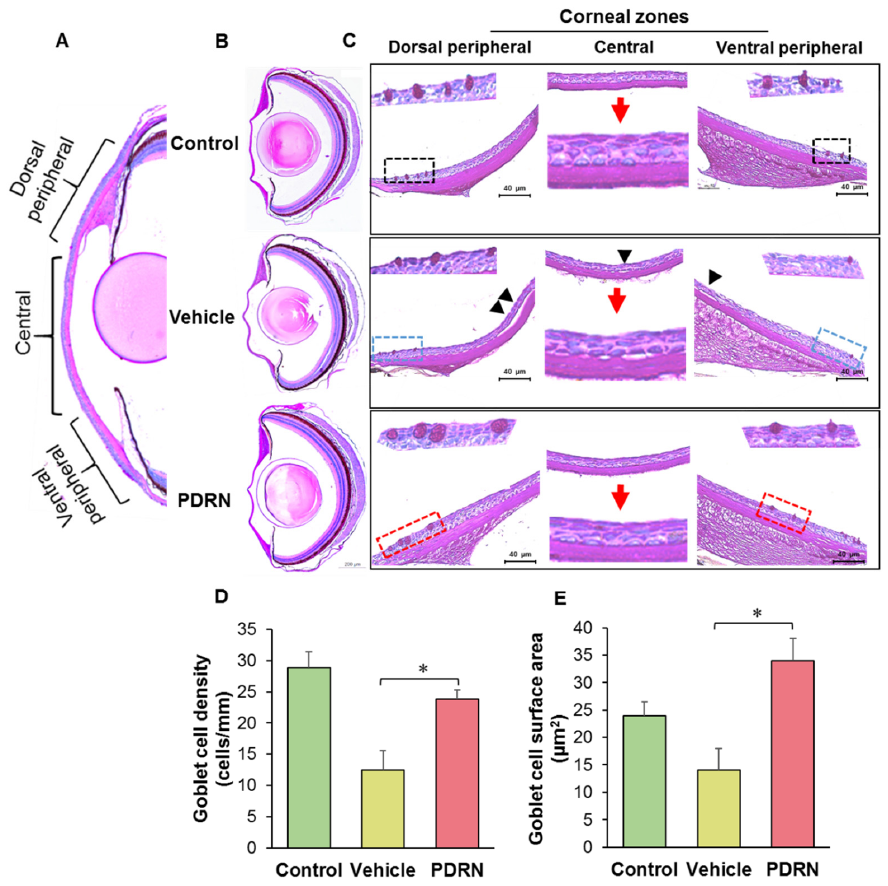
Figure 4. PDRN effect on goblet cell characteristics in the corneal epithelium following the cornea injury and PDRN treatment. ( A ) Magnified transverse sections stained with PAS showing the rep- resentative panoramic overview of three corneal epithelial zones (dorsal peripherals, central, and ventral peripheral) and matured goblet cells at 72 hpi after the cornea injury (Scale bars, 200 µm). ( B ) Images showing the mature goblet cells (red square) in the PDRN-treated group, and ( C ) mag- nified zones showing that the epithelium cells are not well attached (black arrowheads) in the cor- nea- injured vehicle-treated group. The graphs illustrate quantification of ( D ) goblet cell density and ( E ) the goblet cell surface area (an indicator of size) following the cornea injury at 72 hpi. Goblet cell